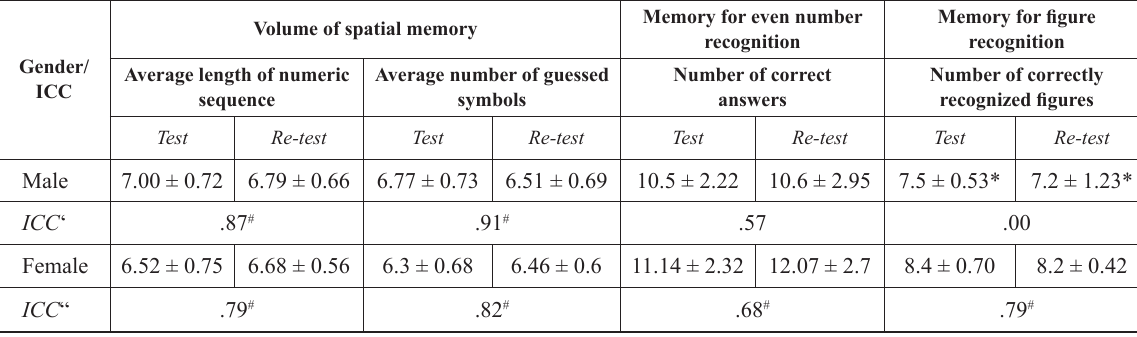
Table 1. Results of the reliability assessment of memory tests for both genders